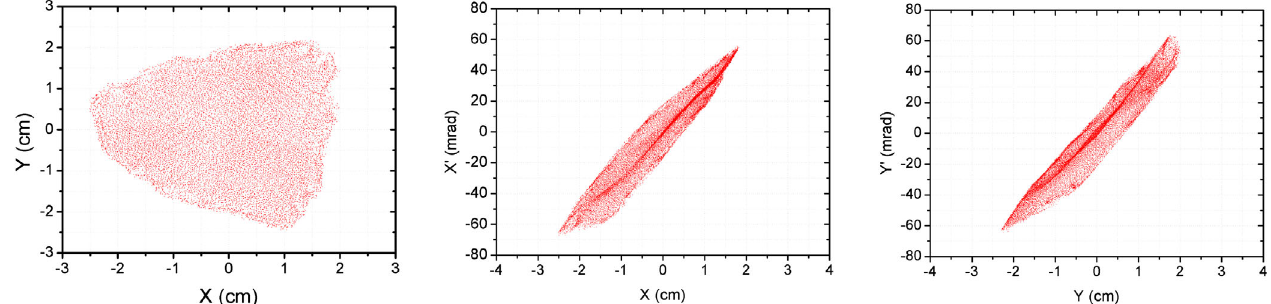
FIG. 4. U 35 þ beam profile in transverse plane and the phase spaces.